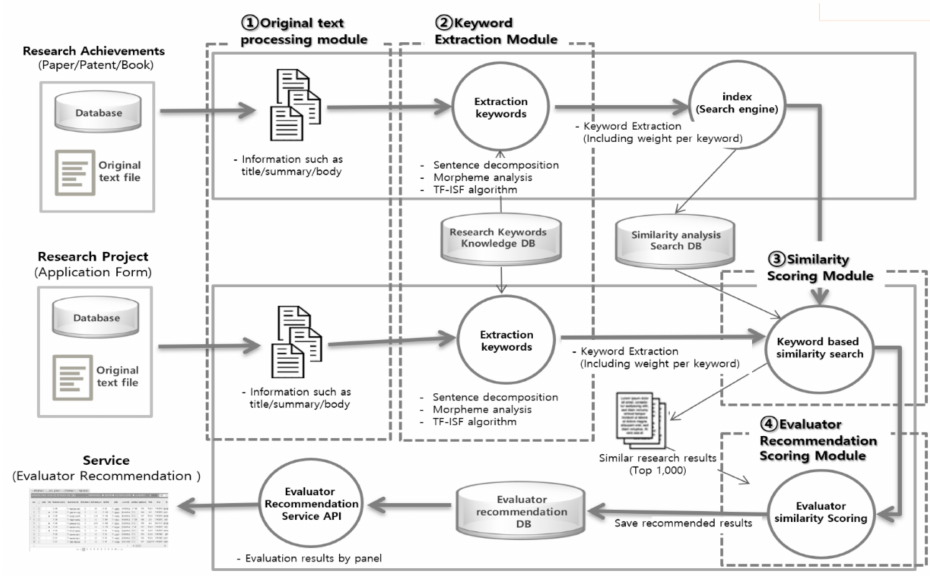
Figure 1. Original text processing